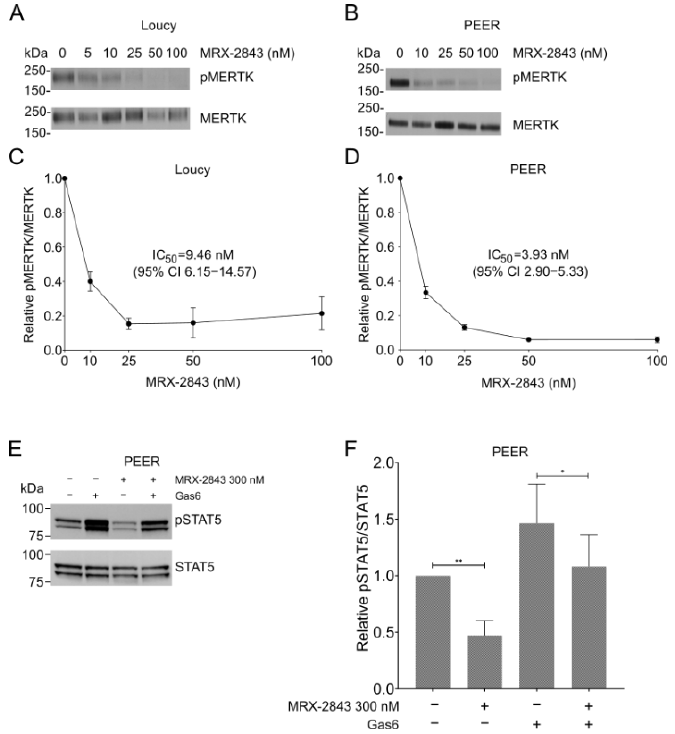
Figure 2. Treatment with MRX-2843 inhibits activation of MERTK in ETP-ALL cell lines in a dose- dependent manner. ( A – D ) Loucy ( A , C ) and PEER ( B , D ) cells were treated with the indicated concentrations of MRX-2843 or vehicle (DMSO). ( A , B ) After 1 h, cells were treated with phosphatase inhibitor; then, cell lysates were prepared, MERTK protein was immunoprecipitated, and pMERTK and total MERTK were detected by immunoblot. Images shown are representative of results ob- tained in three independent experiments. ( C , D ) Proteins were quantitated by densitometry and pMERTK/MERTK ratios relative to vehicle control were determined. IC 50 values were calculated by nonlinear best-fit regression. Mean values and standard errors derived from 3–4 independent experi- ments are shown. ( E , F ) PEER cells were treated with 300 nM MRX-2843 or vehicle with or without Gas6 ligand, and phosphorylated and total STAT5 proteins were detected by immunoblot. Images shown are representative of results obtained in at least three independent experiments. ( F ) Proteins were quantitated by densitometry and pSTAT5/STAT5 ratios were determined relative to vehicle treatment. Mean values and standard errors derived from six independent experiments are